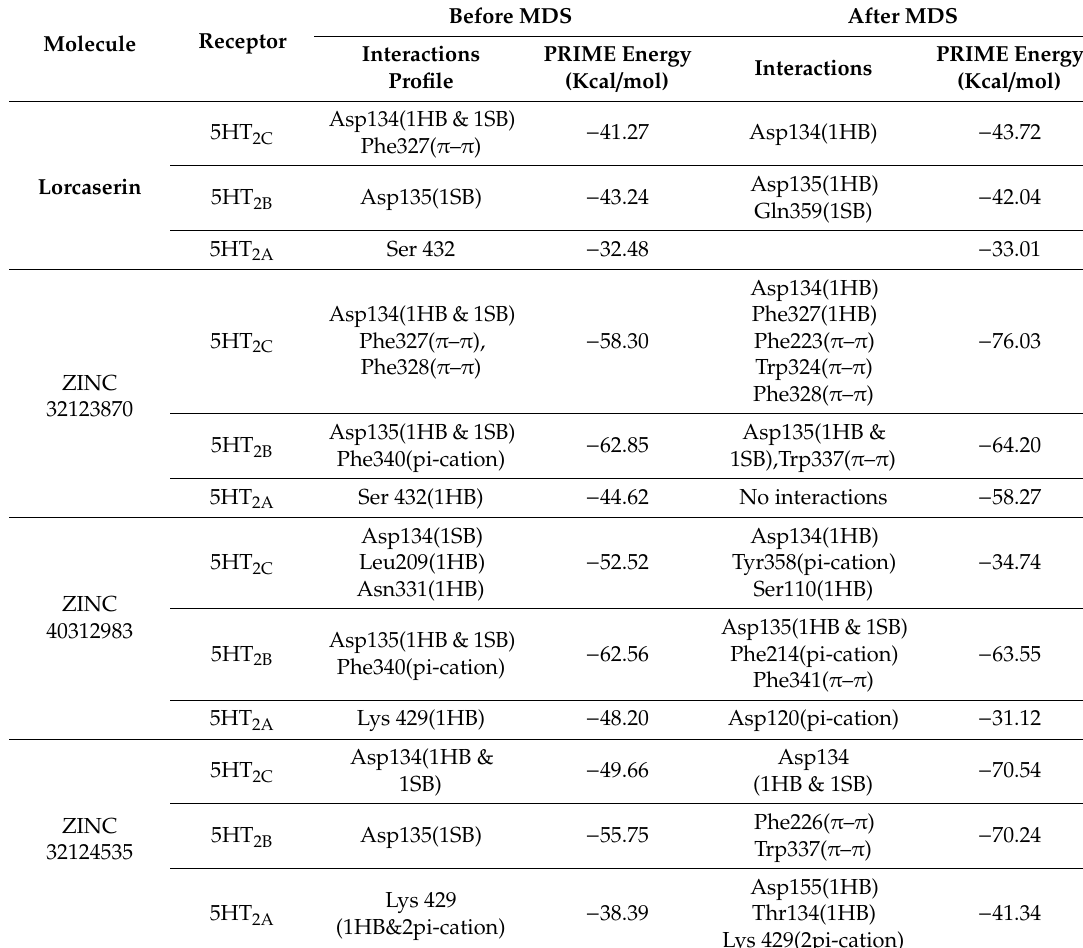
Table 3. Interactions of three potential hits along with known drug during the docking and simulation studies along with PRIME energy